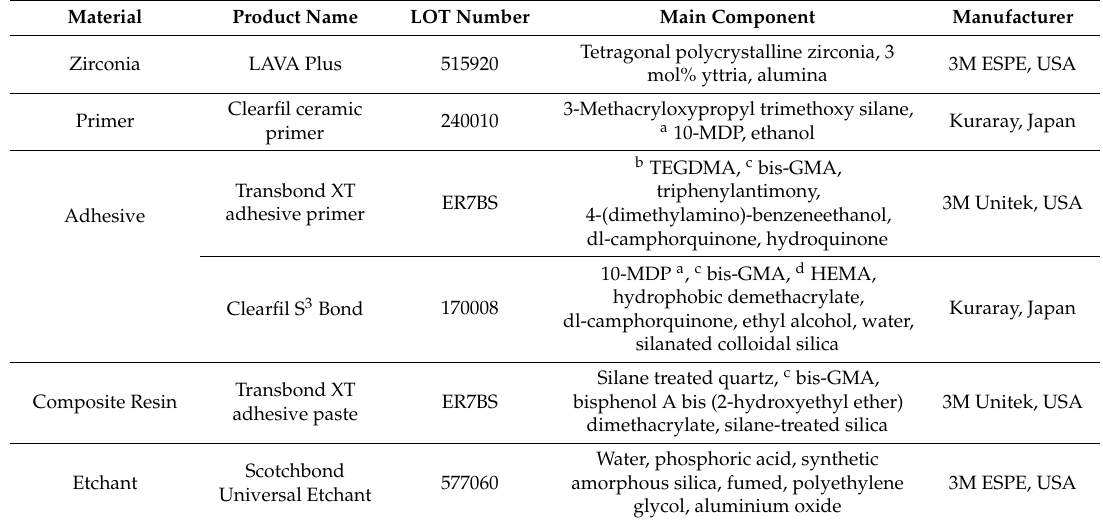
Table 1. Materials used in this